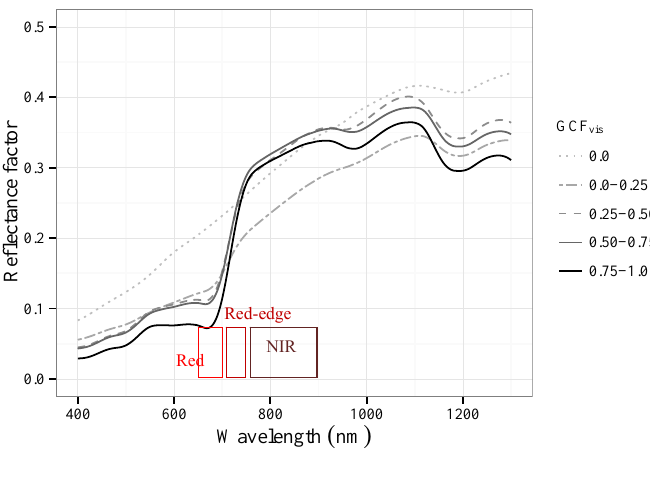
Figure 8. Canopy spectral signature (average) of the 32 Tamarugo trees grouped by GCF measured on 24–28 January 2011. The 50% band pass of the WorldView2 red, red-edge and NIR1 spectral bands are displayed as